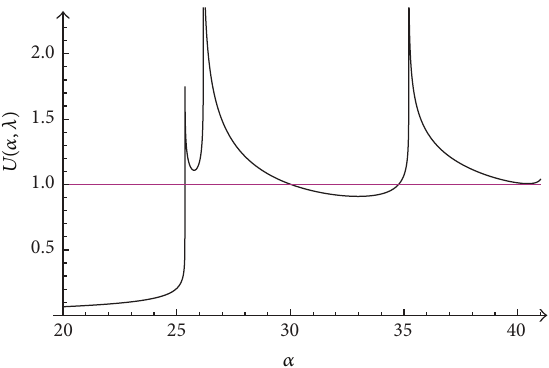
Figure 11: The graph of the function 𝑈(𝛼, 0.02222) .